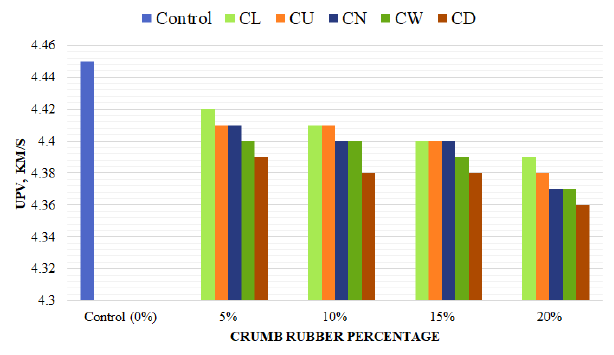
Figure 7. UPV results.